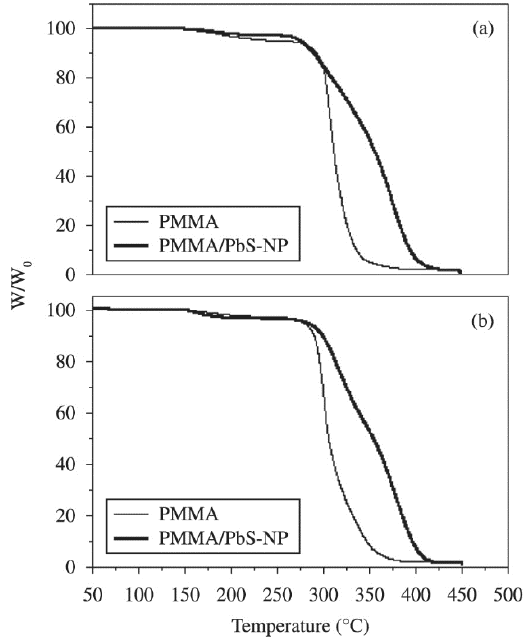
Figure 6. Refractive index of PMMA in function of PbS-NP concentration.